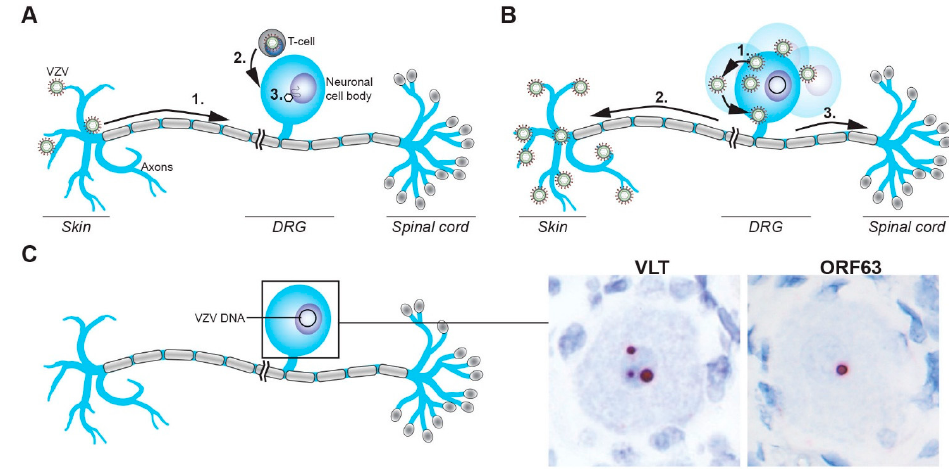
2 Figure 2. Schematic representation of the establishment of, and reactivation from, VZV latency in sensory neurons. ( A ) VZV gains access to sensory ganglion neurons via the infection of nerve endings in skin and retrograde axonal transport to the neuronal cell body (1) or direct infection of cell bodies via VZV-infected T-cells (2), followed by the release of the viral genome into the nucleus (3). ( B ) VZV reactivation results in virus replication and spread in the cell body (1), followed by transaxonal spread to the skin to cause HZ (2), possibly involving concordant virus spread to the spinal cord (3). ( C ) VZV latently infected sensory neurons contain viral episomal DNA in their nuclei and express VLT and/or ORF63 RNA, as shown by RNA in situ hybridization on human TG (red signal). Magnification: 400 × with 2.5 × digital